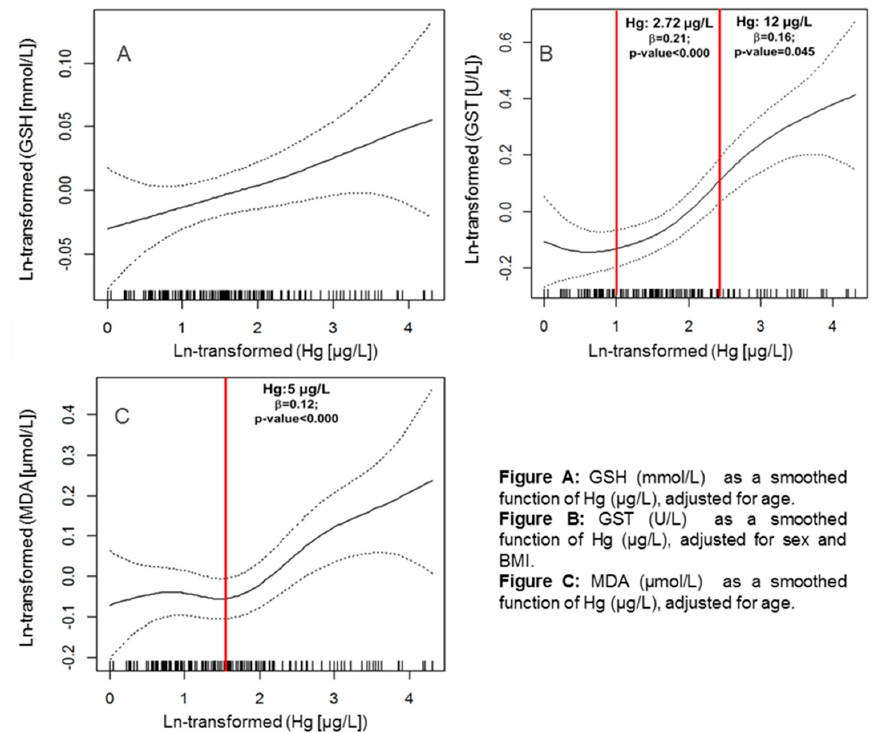
Figure 4. Smoothed function of oxidative stress biomarkers and their relationship with Hg. ( A ) GSH as a smoothed function of total mercury concentrations in blood (Hg-B), coefficient of ln (Hg): 0.024 ( p -value = 0.052). ( B ) GST as a smoothed function of Hg-B. ( C ) MDA as a smoothed function of Hg-B. The relationship between GSH and Hg was linear. The relationship between Hg and GST was established using a spline with 2 knots inserted in the ln-transformed values of Hg (1 and 2.5 (cid:27) 2.72 and 12 µ g / L of Hg). The relationship between Hg and MDA was established using a spline with df =